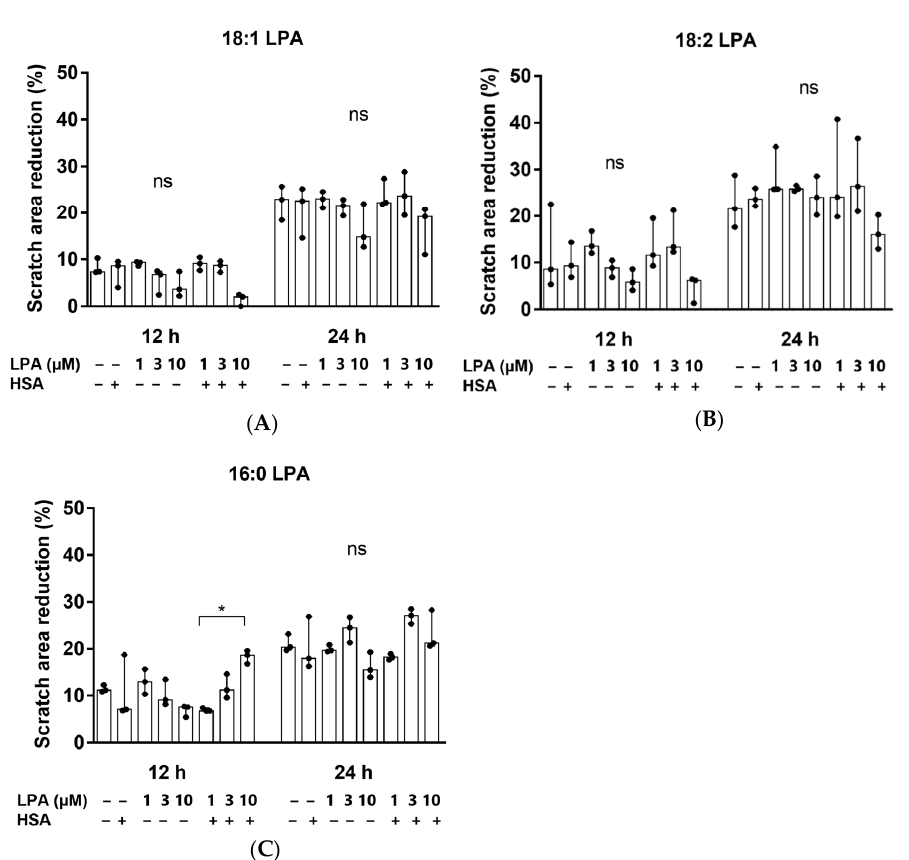
Figure 4. Scratch area reduction (%) after treatment with ( A ) 18:1, ( B ) 18:2 and ( C ) 16:0 LPA species for 12 and 24 h. hBM-dMSCs were treated with different LPA species in 1 µM, 3 µM, and 10 µM concentrations alone or in combination with HSA (* p < 0.05, n = 3, Kruskal–Wallis test followed by Dunn’s multiple comparison test). Data are presented as the median and interquartile range. The migration rate is expressed as the percentage of area reduction.